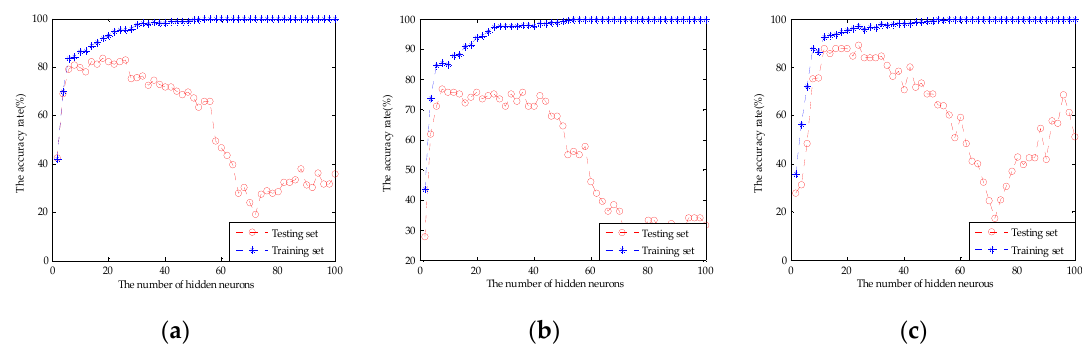
Figure 11. The classification performance of the ELM based on the number of hidden neurons: ( a ) e-tongue; ( b ) e-nose; and ( c ) the original fusion set. Table 3. Comparison of results for different fusion feature sets.